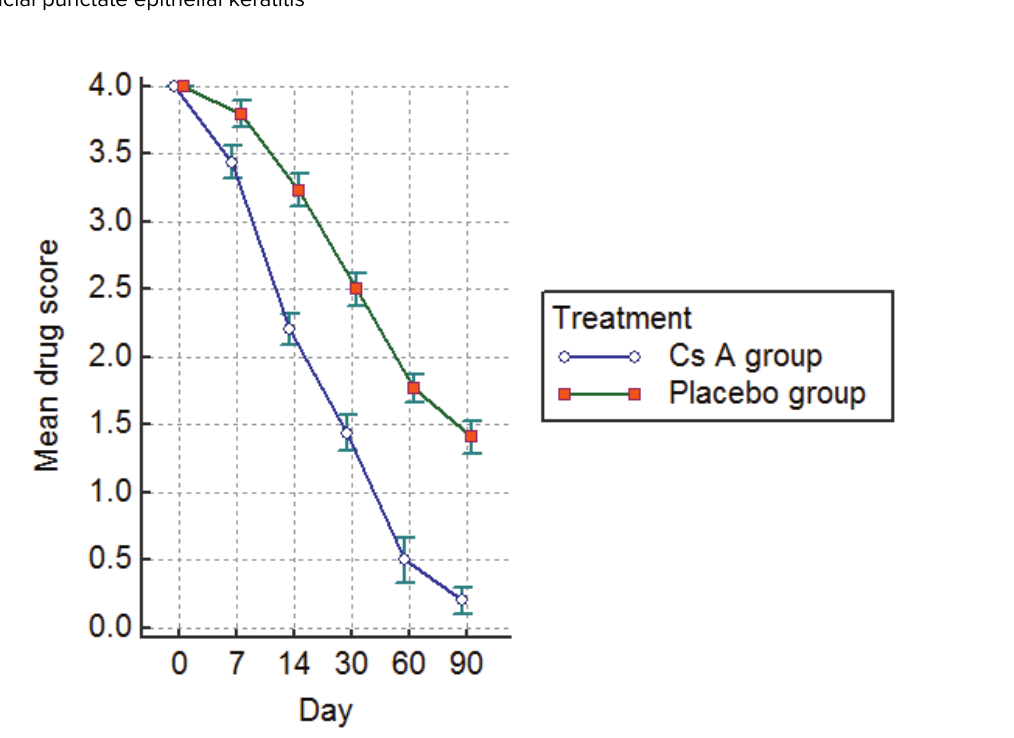
Figure 3. Mean steroid drop usage per day per eye (drug score) at baseline and during follow-up